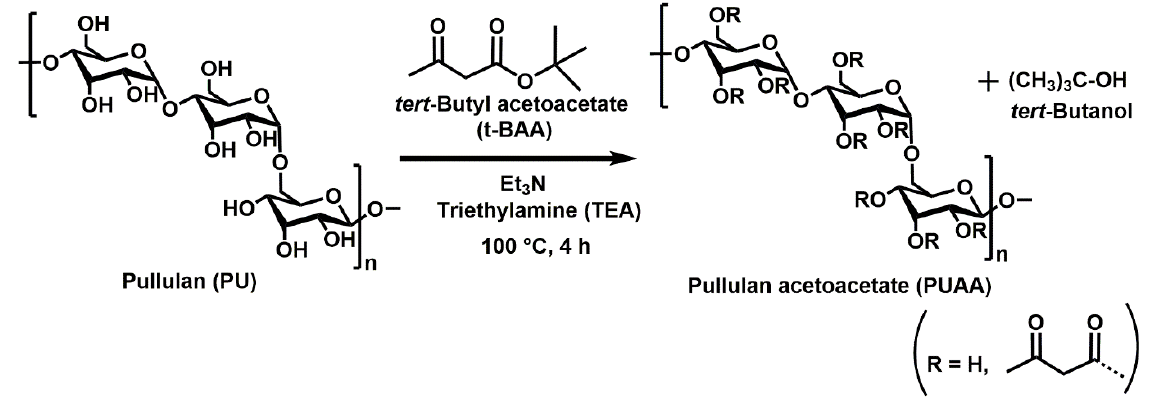
Figure 1. Schematic of synthesis of